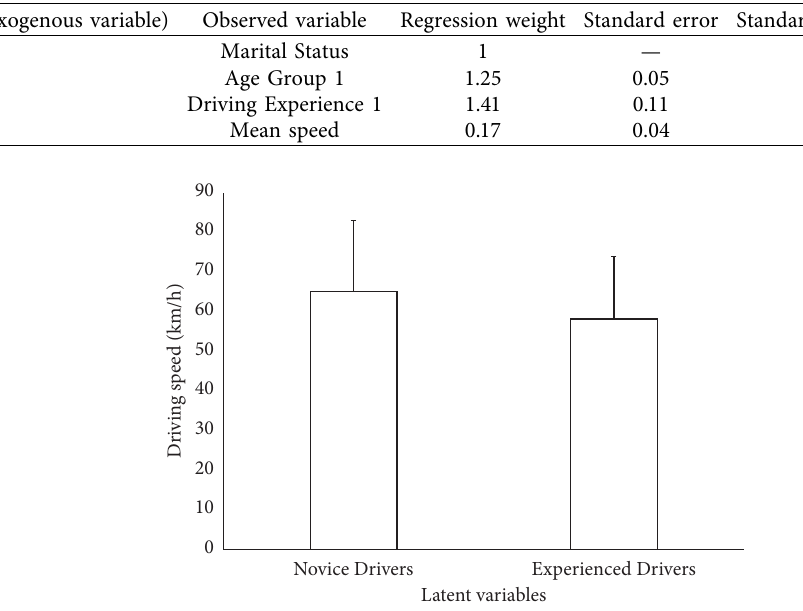
Figure 8: Speed statistics of two latent variables: “Experienced Drivers” vs “Novice